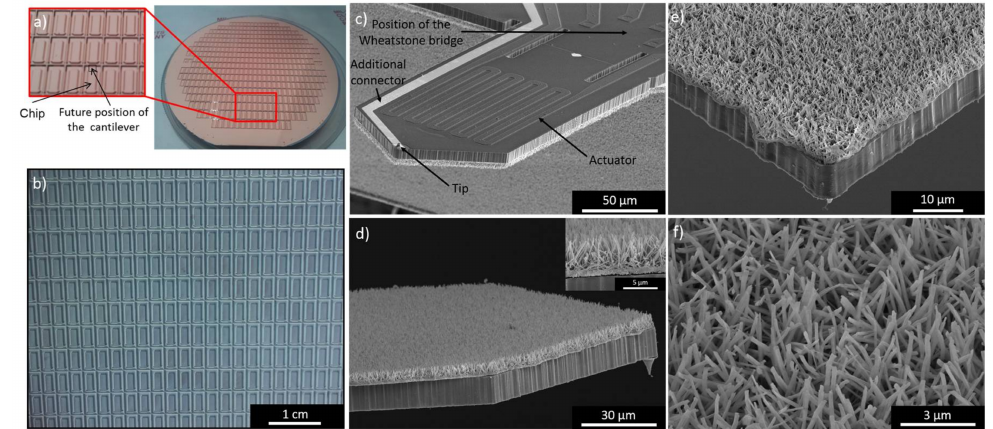
Figure 3. Photography of the 4” wafer used for the production of piezoresistive cantilevers: ( a ) before the nanostructures growth; and ( b ) after the Cu(OH) 2 nanorods synthesis; ( c – f ) Scanning electron microscopy (SEM) tilted view of the nanostructured cantilevers; ( c ) Cantilever face showing